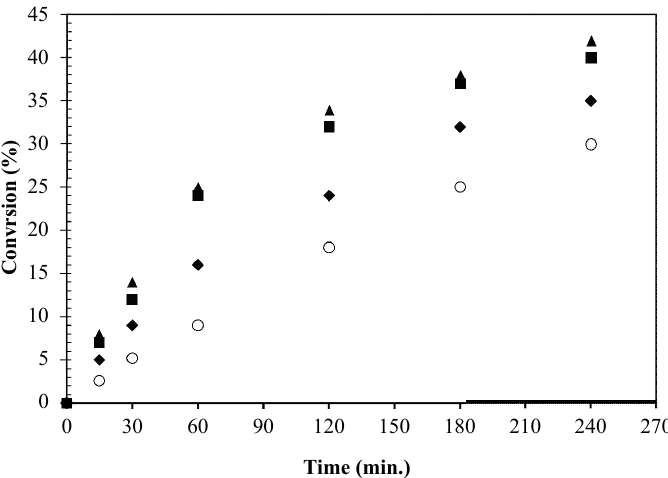
Time (min.) Figure 6. Effect of catalyst loading. Speed of agitation: 1000 rpm, temperature: 150 °C, mole ratio Glycerol:BA = 1:3, reaction duration 4 h. ( ) 0.01 g/cm 3 ; ( ) 0.02 g/cm 3 ; ( ) 0.03 g/cm 3 ; ( ) 0.04 g/cm 3 .